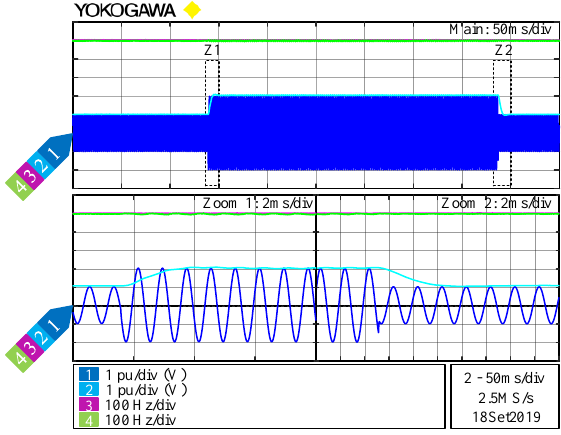
Figure 23. Experimental results related do Test 2—amplitude steps 1-2-1 pu.